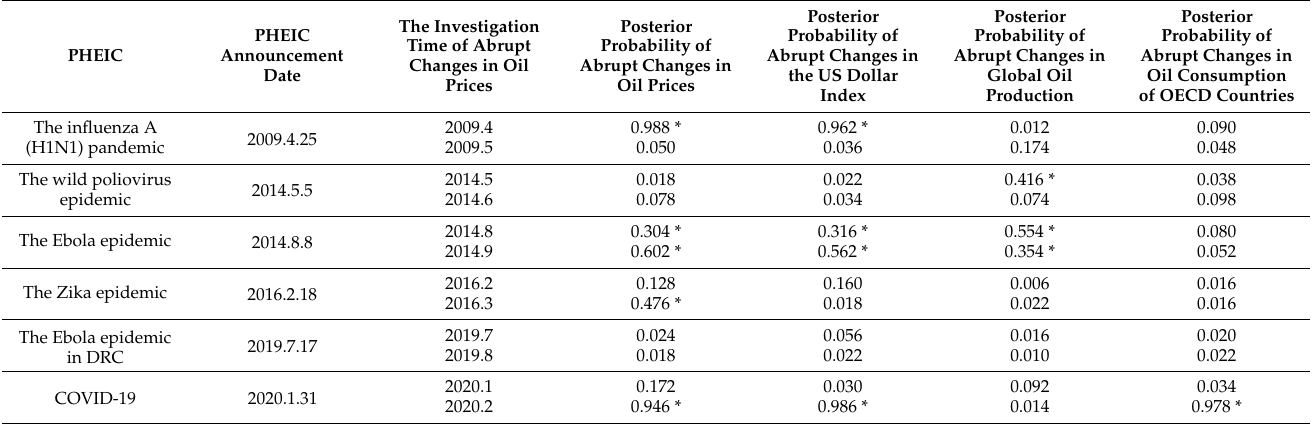
Figure 4. PPM calculation results of oil consumption of OECD countries and corresponding posterior mean and posterior probability since 2009 (source: EIA). Table 2. Changes in WTI oil price, US dollar index, global oil production, and oil consumption of OECD countries during PHEIC.